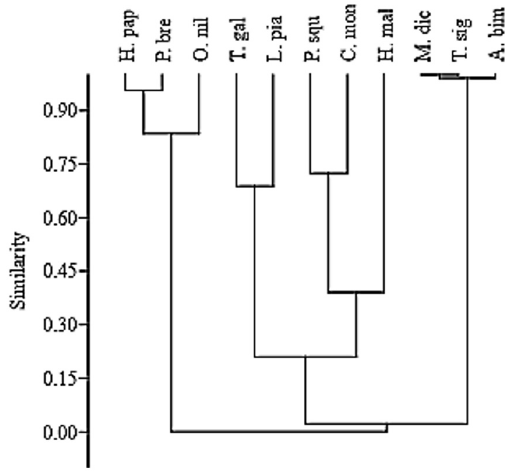
Figure 2. Dendrogram of food similarity from the values of the Feeding Index (IAi) of the 11 fishes’ species studied in the Umari reservoir, Rio Grande do Norte, Brazil. Trophic Guilds: Malacophagous ( Leporinus piau ; Triportheus signatus ); Carcinophagous ( Cichla monoculus ; Plagioscion squamosissimus ); Piscivorous ( Hoplias gr. malabaricus ); Insectivorous ( Astyanax bimaculatus ; Moenkhausia dichroura ; Triportheus signatus ); Detritivorous ( Hypostomus pusarum ; Prochilodus brevis ; Oreochromis niloticus